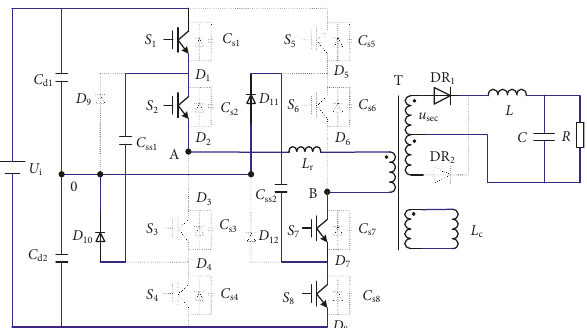
Figure 8: Equivalent circuit of mode